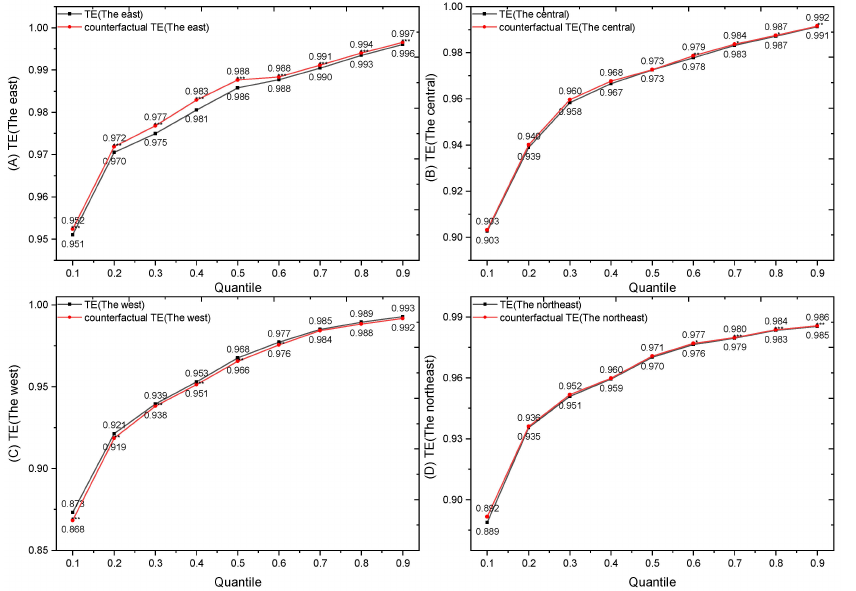
Figure 5. Comparison between the energy industrial chain technology efficiency measured in this paper and the counterfactual estimation of energy industrial chain technology efficiency. Note: *** p < 0.01, ** p < 0.05, * p <